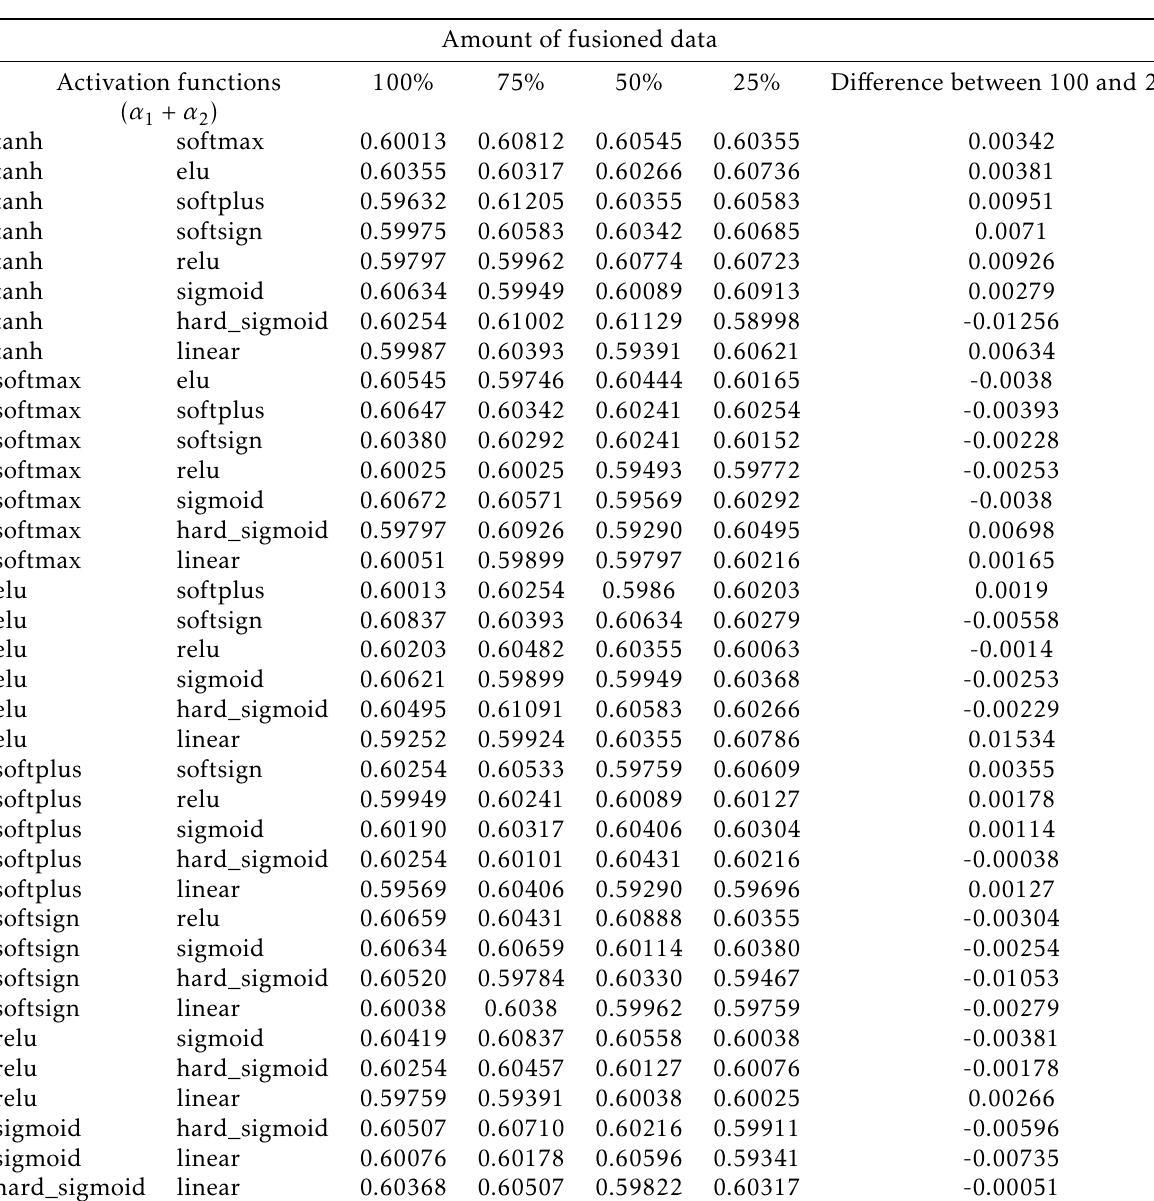
Table 4. Full results of the tuples for the activity recognition models for Subject 4. Complementary information of Table